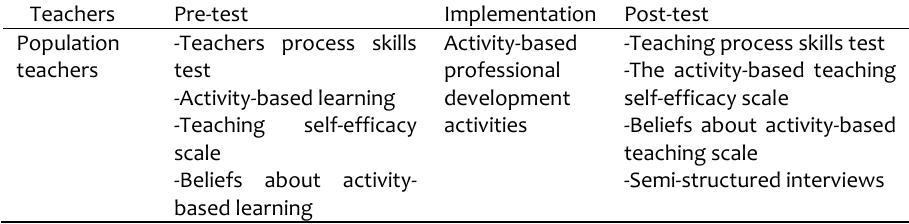
Table 1. Experimental Process of the